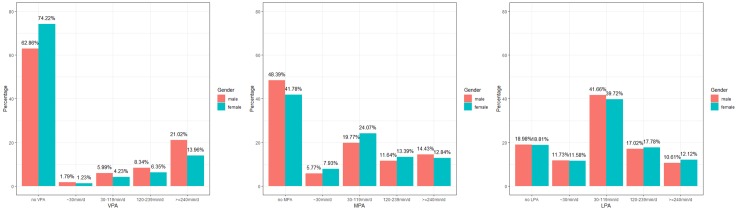
Duration per time for VPA, MPA and LPA in men and women.